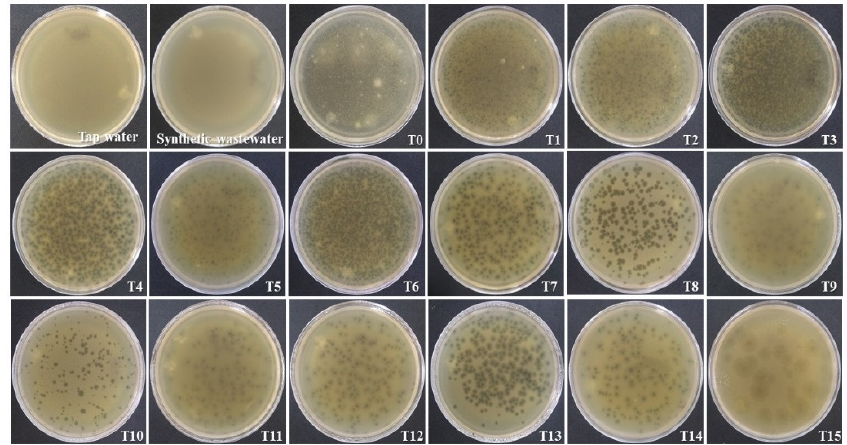
Figure 3. Samples taken from bioelectrochemical treatment system with coliphage MS2, using double-layer method. Negative controls (tap water and synthetic wastewater) and samples taken at times 0–15 h (T0–T15), every hour.